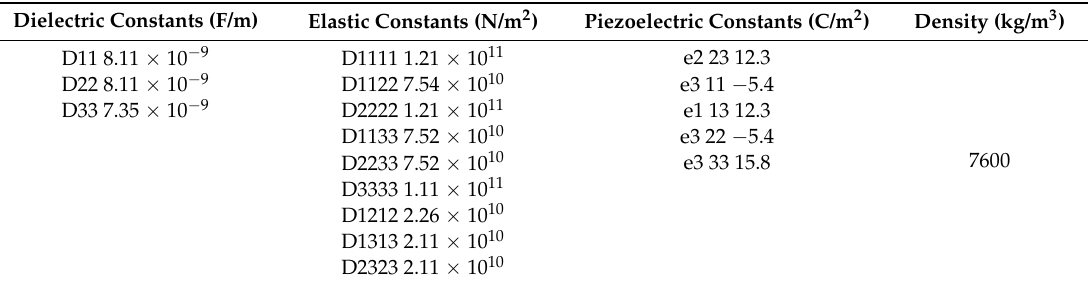
Table 2. The mechanical and electrical parameters of PZT materials 1 .